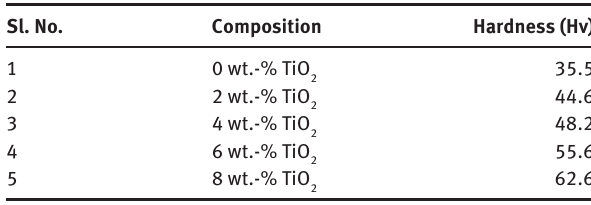
-filled A384 alloy composites. 2